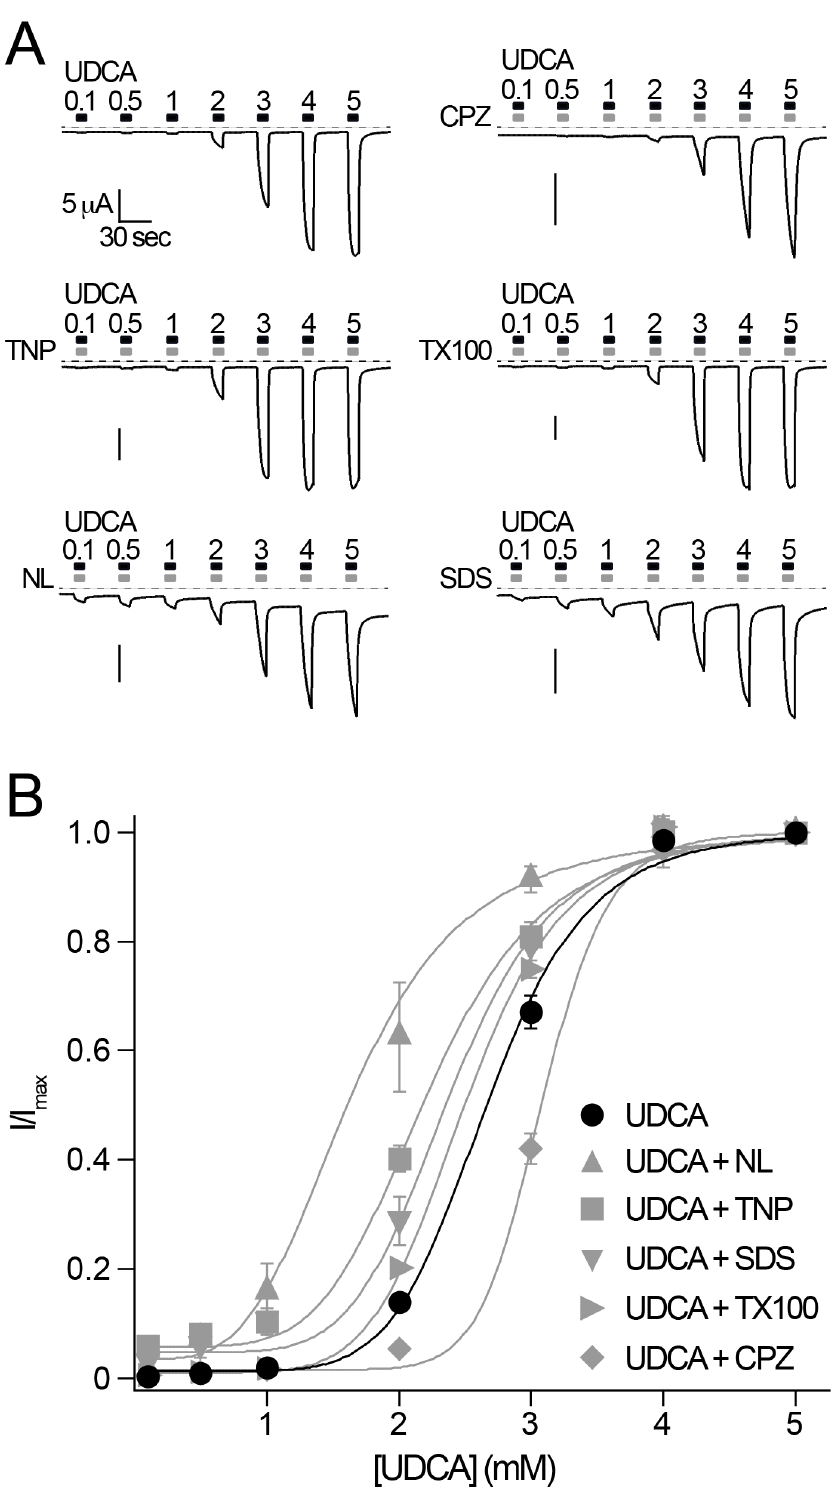
Figure 5. Bile acids and other membrane-active substances activate BASIC by a similar mechanism. A) Representative current traces of BASIC showing the concentration-dependent activation of BASIC by UDCA in the absence and presence of membrane active substances (CPZ, 500 m M; TNP, 2 mM; TX100, 100 m M; NL, 500 m M or SDS, 400 m M). Dotted lines represent the 0 current level B) Concentration-response curves for UDCA in the presence and absence of membrane active substances. Currents were normalized to the maximum current at 5 mM UDCA, which was 23.8 6 2.4 m A. Error bars=S.E.M., n =10. Curves represent fits to the Hill equation (equation (1)).